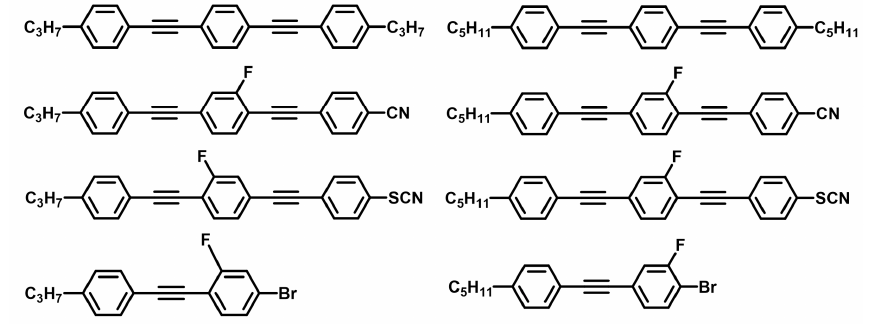
Figure 1. Chemical structures of the eight liquid crystal (LC) monomers.